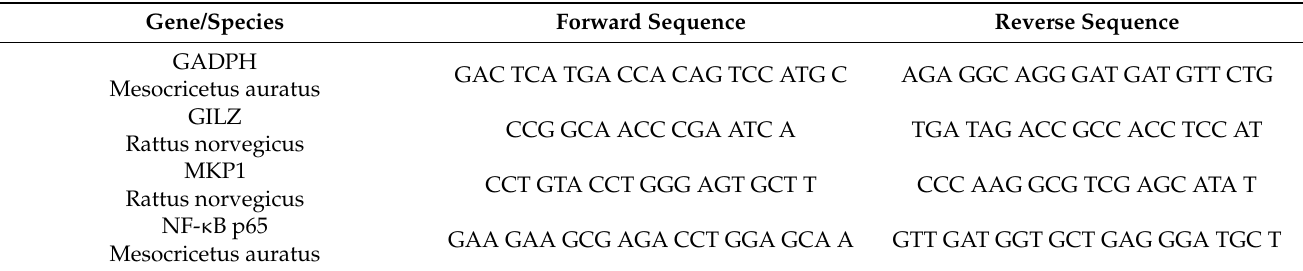
Table 1. Primer sequences designed in Primers Express™ for